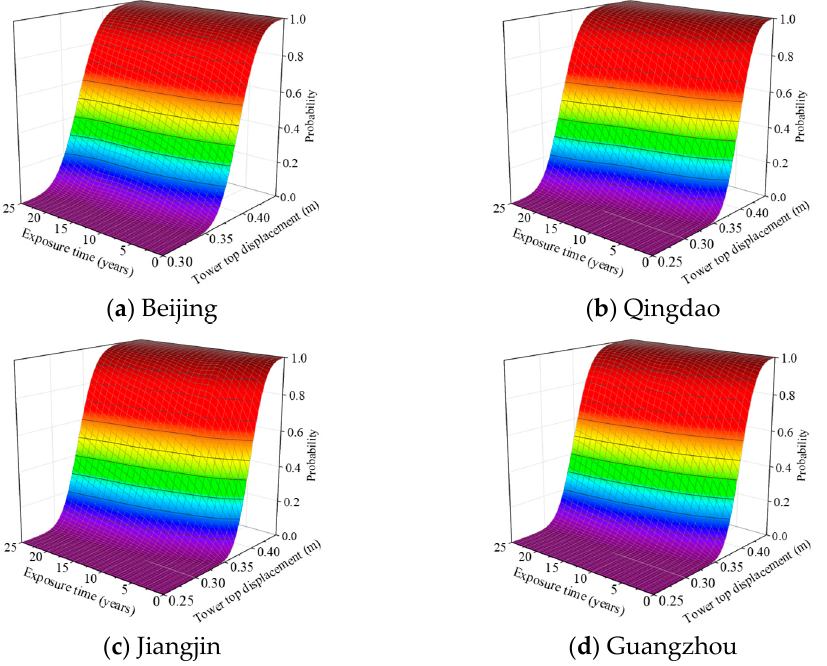
Figure 20. Fragility surface of the collapsed-tower top displacement in each region.